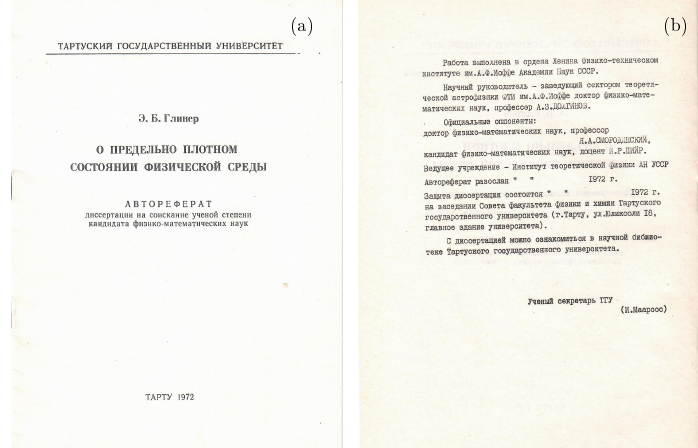
Figure 2. Cover page of Gliner’s dissertation summary (in Russian). ( a ) The author’s name, PhD title, defense location (Tartu University) and year: 1972. ( b ) Names of scientific adviser, and both reviewers. See the text for details. From archive of DY.